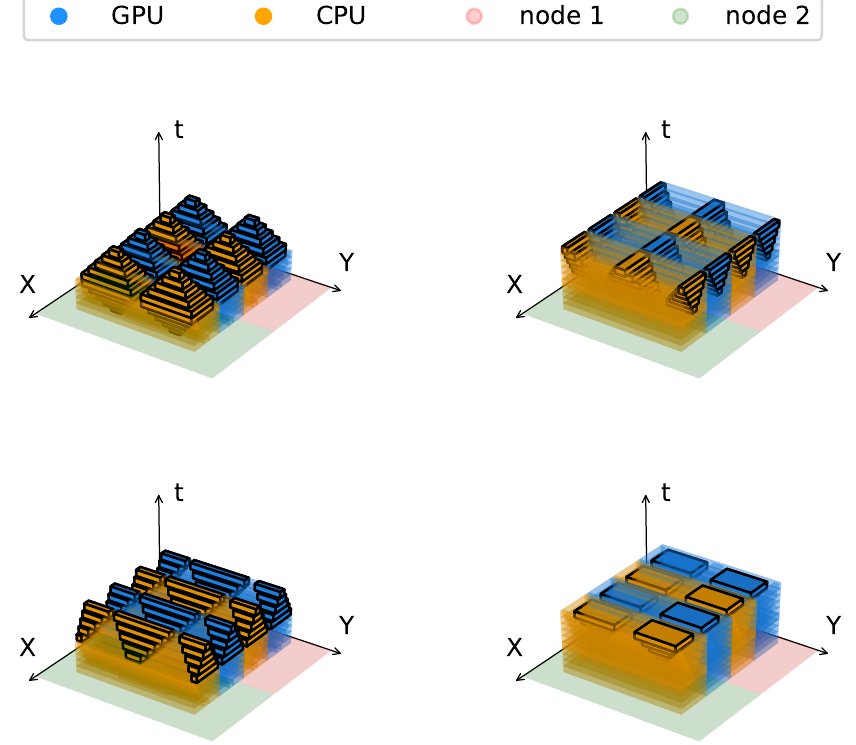
Figure 4. The intermediate and final steps of the swept solution: Octahedron ( top left ), X-Bridge ( top right ), Y-Bridge ( bottom left ), and Down-Pyramid ( bottom right